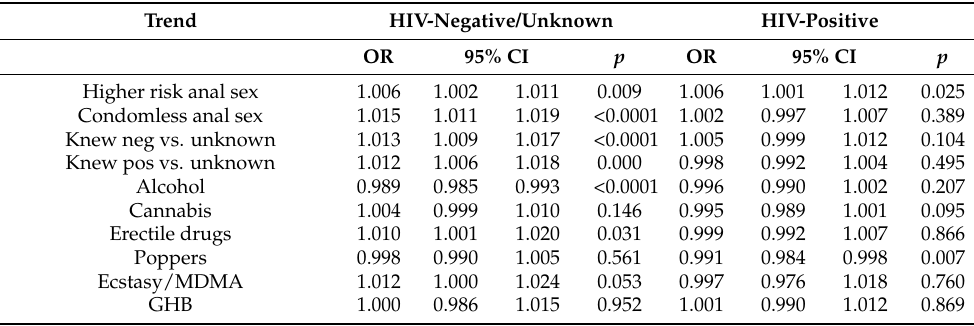
Table 3. Univariable temporal trends and interactions of substance use and higher risk anal sex prevalence among gbMSM in Metro Vancouver, 2012–2017.